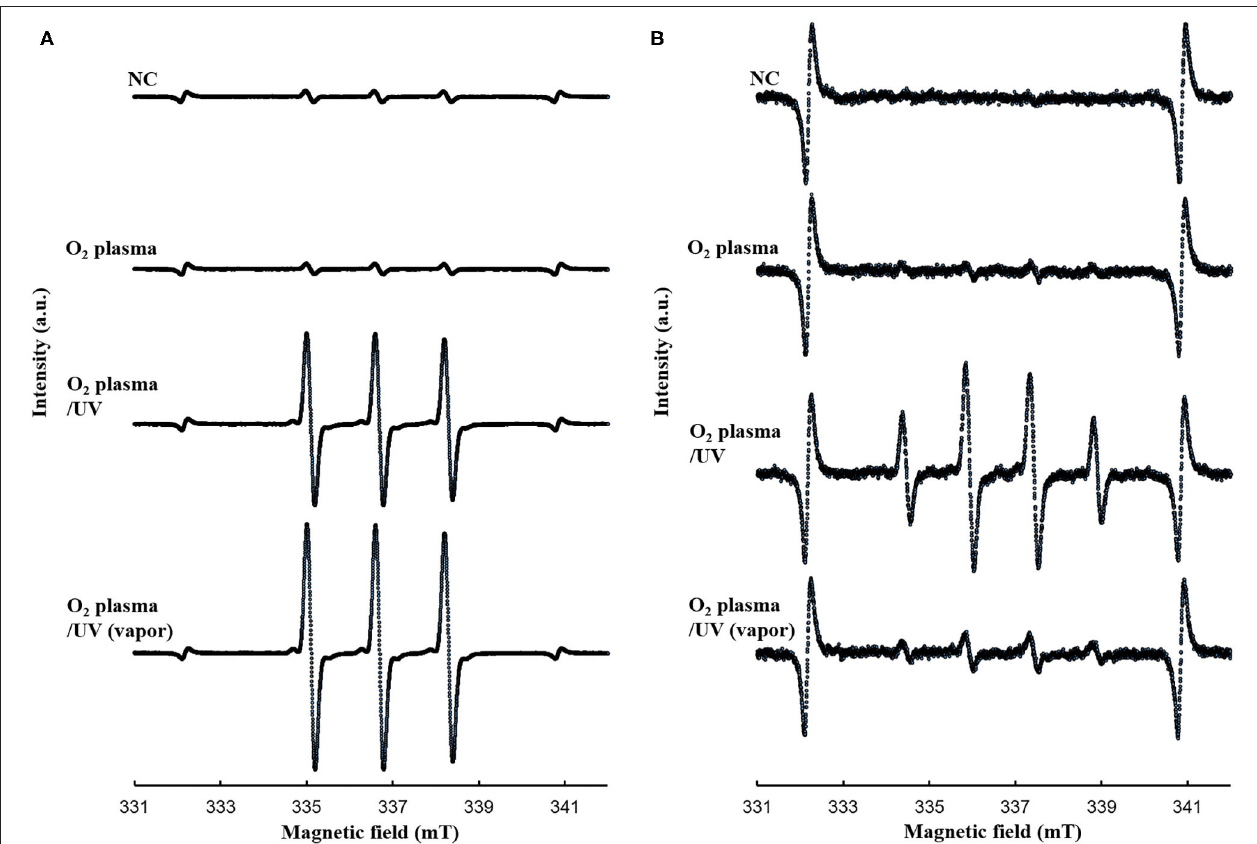
FIGURE 6 | ESR spectra for (A) TPC- 1 O 2 and (B) DMPO-OH. A 0.5mM DMPO or 0.5mM TPC solution was processed in each RVR condition [NC, O 2 plasma, O 2 plasma/UV, and O 2 plasma/UV (vapor)] for 120 sec. Details of the ESR conditions are provided in the methods section. NC, O 2 plasma, O 2 plasma/UV, and O 2 plasma/UV (vapor) condition are indicated. Analyzed values are shown in Table 2 . Y-axis indicates intensity (arbitrary unit).